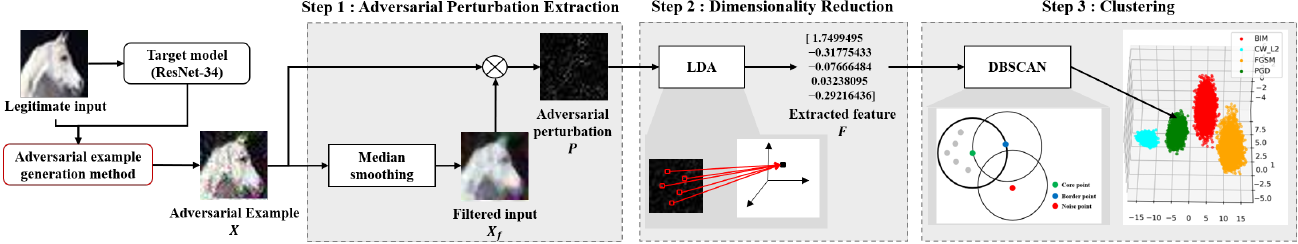
Figure 5. Operational example of the proposed method with LDA and the DBSCAN